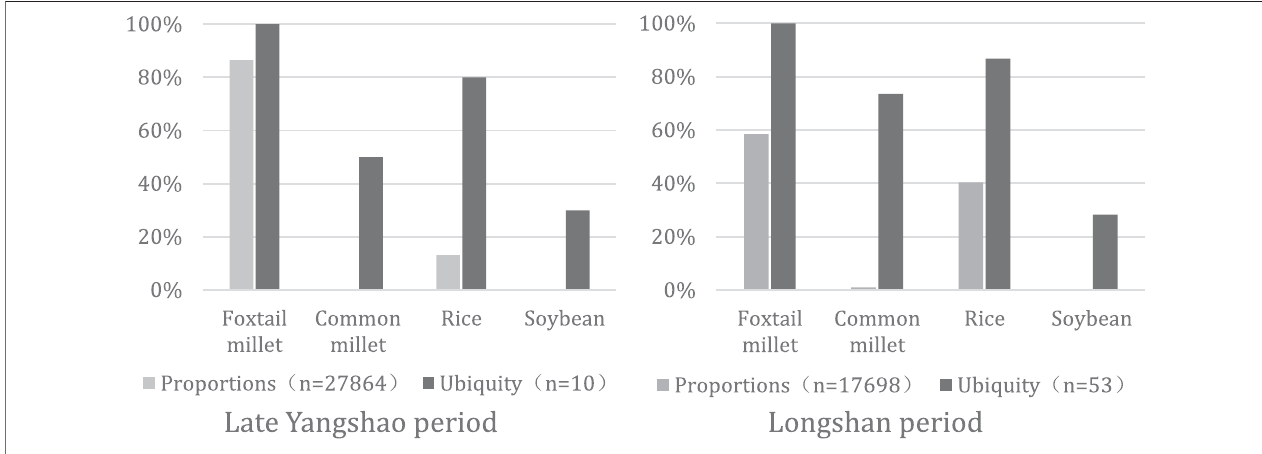
FIGURE 3 | Proportions and ubiquity of crops at the Suyang site (Late Yangshao period and Longshan period).